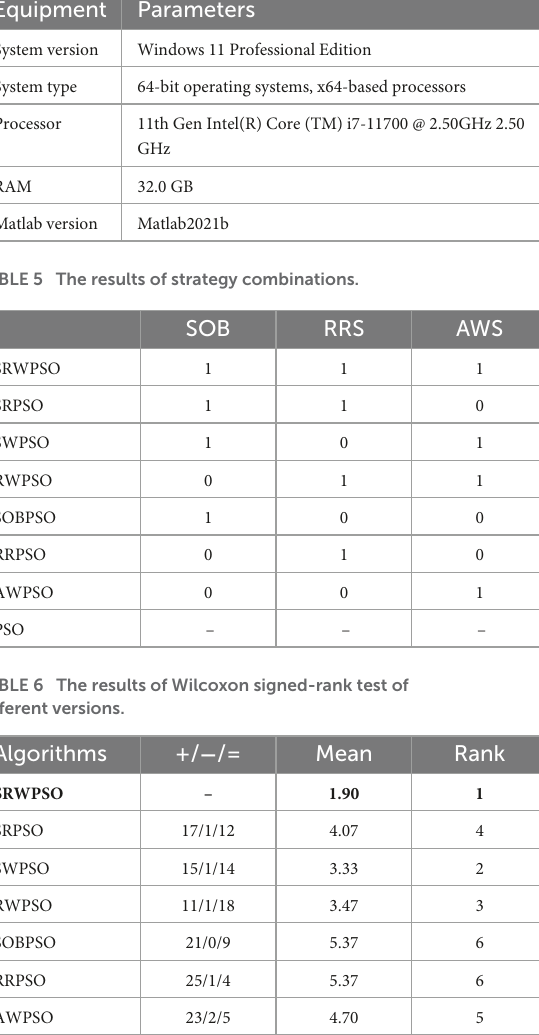
TABLE 4 Description of the experimental environment.